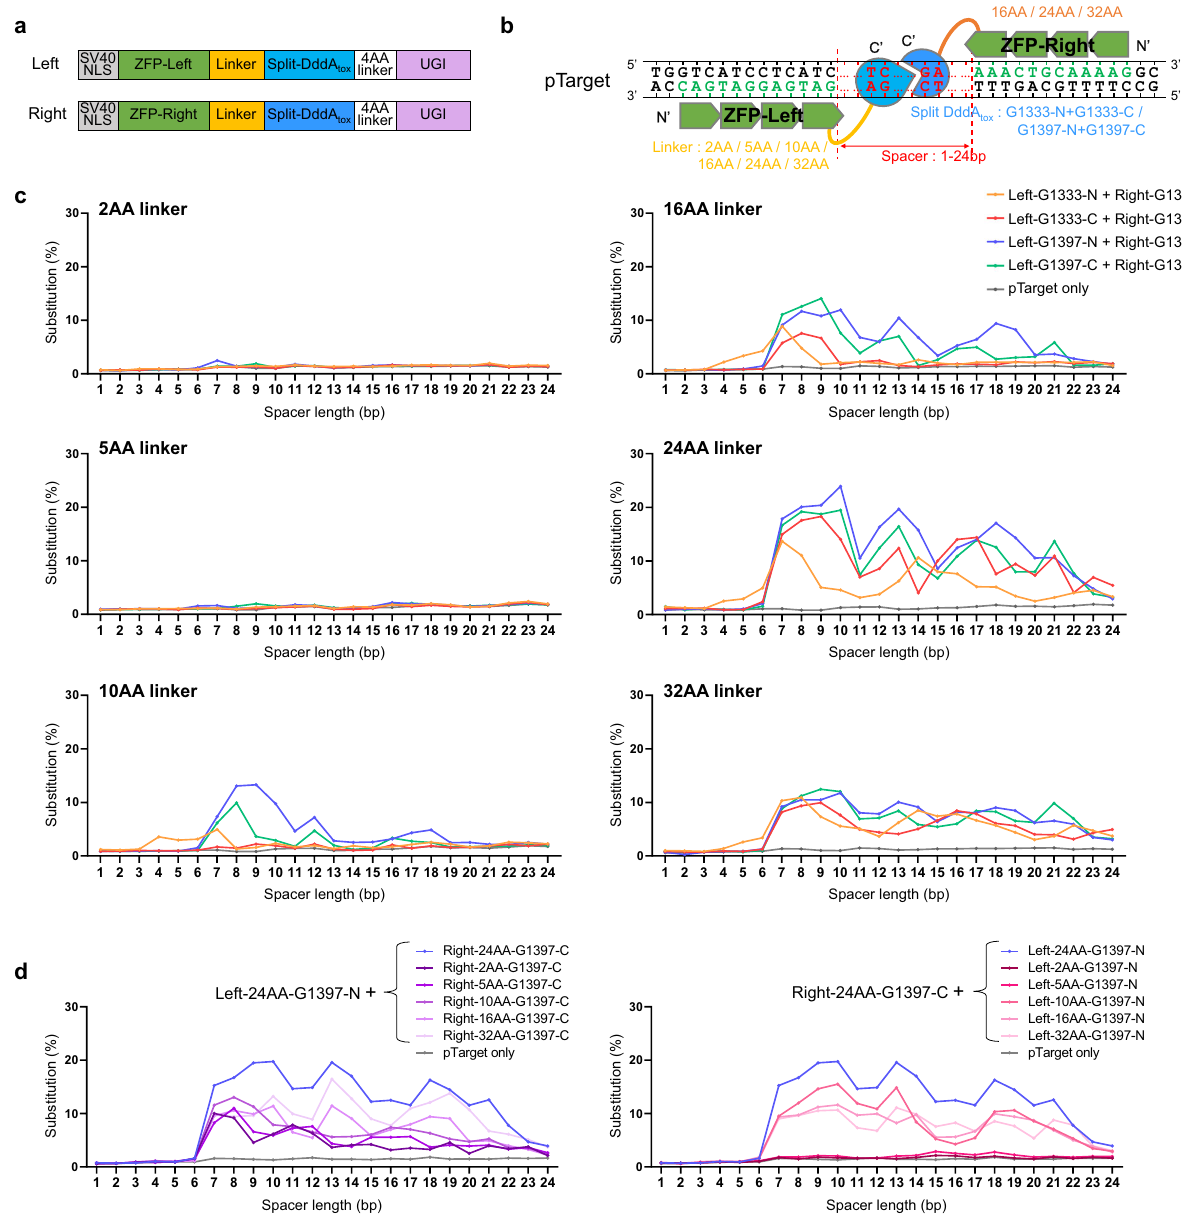
Fig. 1 Development of ZFDs. a ZFD (zinc fi nger deaminase) architecture. Split-DddA tox halves are fused to the C terminus of ZFPs (zinc fi nger proteins) (C type). b Optimization of the ZFD platform using pTarget libraries. pTarget plasmids contain a spacer region that ranges in size from 1 – 24 bp (shown in red) and ZFP DNA binding sites (shown in green). ZFD constructs contain AA (amino acid) linkers of different lengths (shown in yellow and orange) and different DddA tox split sites and orientations (shown in blue). c , d ZFD activities were measured at on-target sites in the pTarget library to examine the effect of the variables described in ( b ). ZFD pairs with linkers of the same ( c ) or different ( d ) lengths in the left and right ZFD were tested. Base editing frequencies were measured by targeted deep sequencing of the relevant region of pTarget plasmids. Data are shown as means from n = 2 biologically independent samples. Source data are provided as a Source Data fi